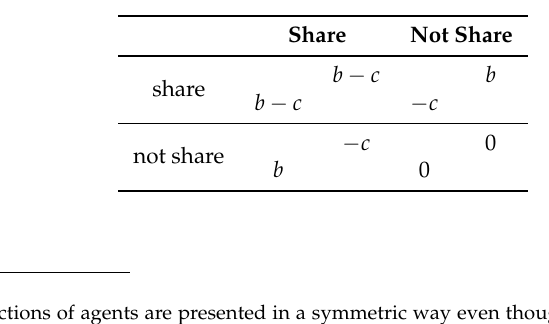
Table 1. Payoff matrix of agents in the repeated interaction model 3